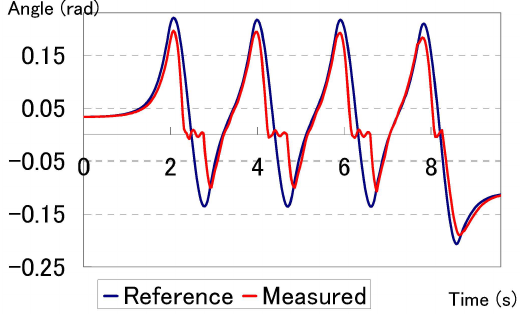
Figure 5. Position of the left ankle pitch joint for hybrid walking control.